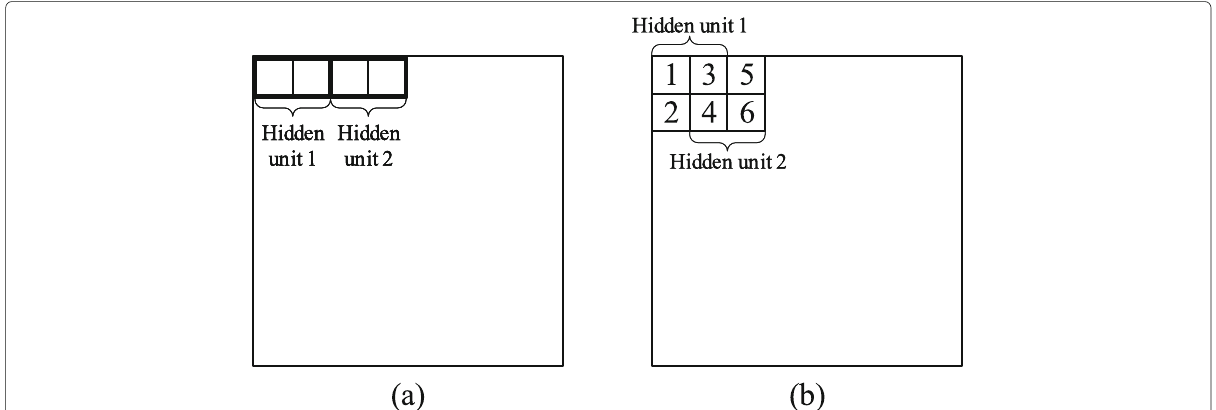
Fig. 8 a Tian’s method: unit1 and unit2 have no overlapping part. b Thoid’s method: unit1 contains pixel 1, pixel 2, pixel 3, and pixel 4. Unit2 contains pixel 3, pixel 4, pixel 5, and pixel 6. Therefore, pixel 3 and pixel 4 are overlapping pixels